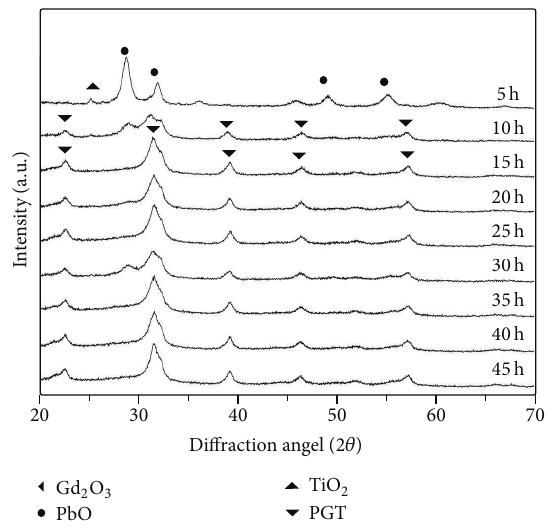
Figure 1: XRD pattern of PGT nanoceramics with 𝑥 = 0.01 at different milling times.